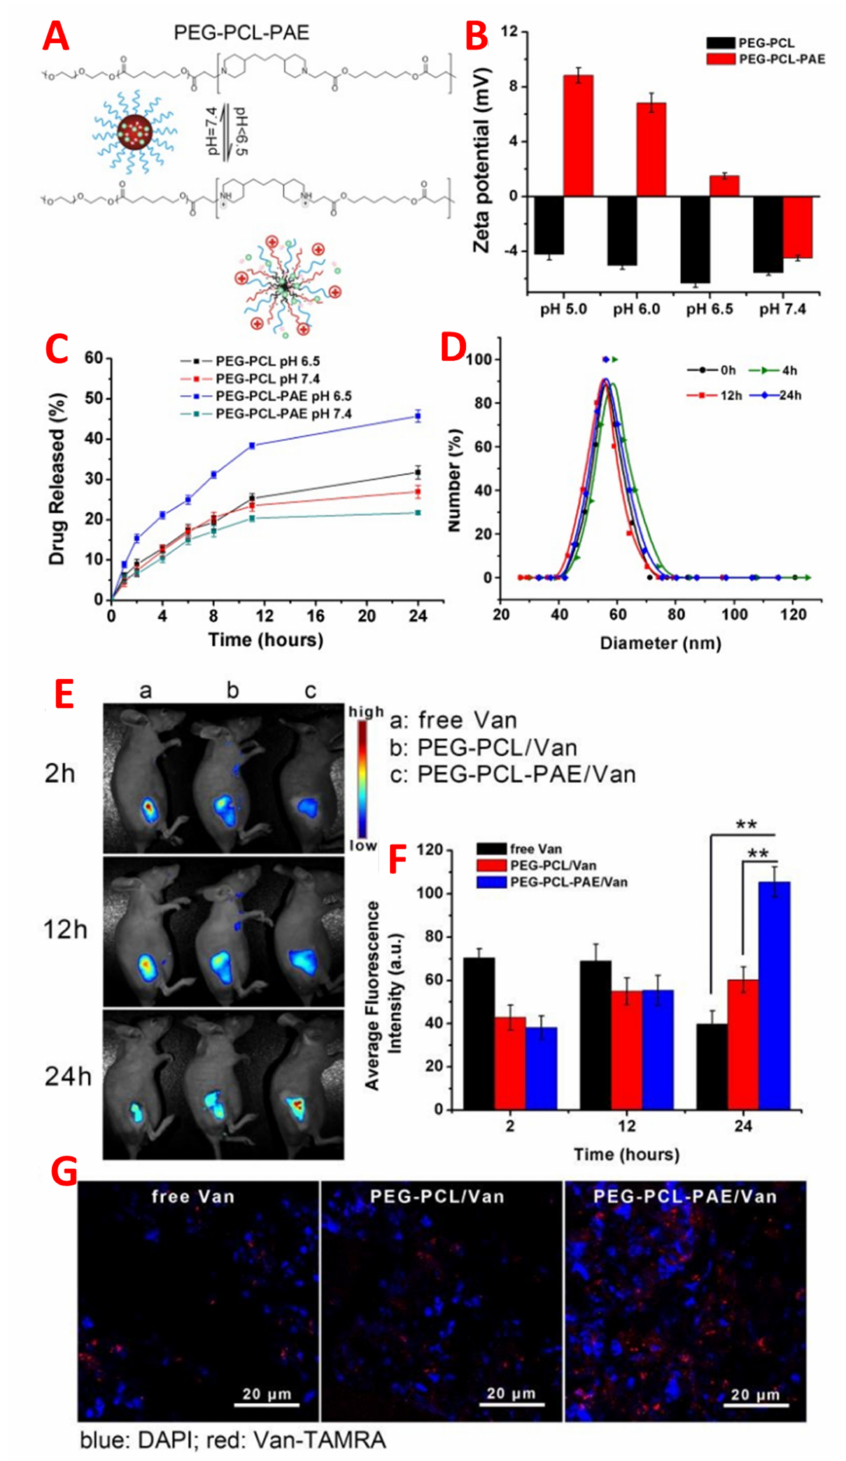
Figure 6. ( A ) Schematic charge conversion of PEG-b-PCL-bPAE/Van nanoparticles due to pH. Zeta potential ( B ) and in vitro Van release ( C ) profiles of PEG-b-PCL/Van and PEG-b-PCLb-PAE/Van nanoparticles under different pH conditions ( n = 4). ( D ) In vitro stability of PEG-b-PCL-b-PAE/Van nanoparticles in PBS buffer (0.01 M) for 24 h. ( E ) In vivo fluorescence images of inflammation-bearing mice after 2 h, 12 h and 24 h of Van injection and ( F ) statistical analysis and ( G ) representative CLSM images of cutaneous inflammation slices from inflammation-bearing mice after 24 h of Van injection. ( n = 3, ** p < 0.01). Adapted with permission from [51], Royal Society of Chemistry,